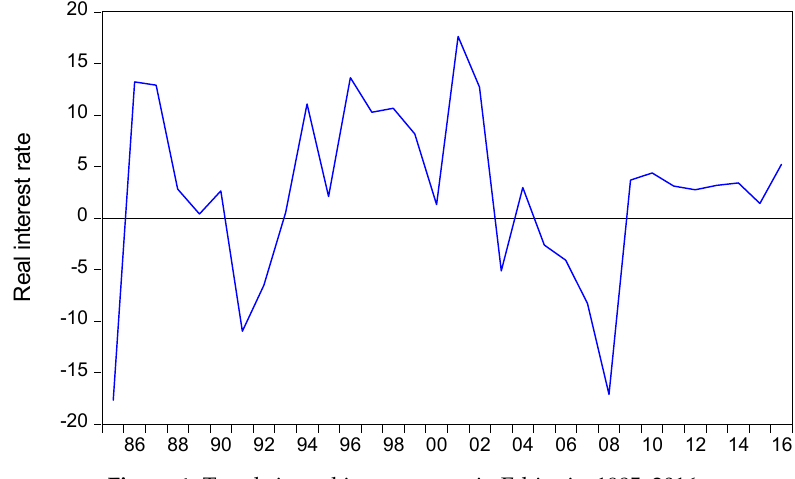
Figure 1. Trends in real interest rates in Ethiopia, 1985–2016.